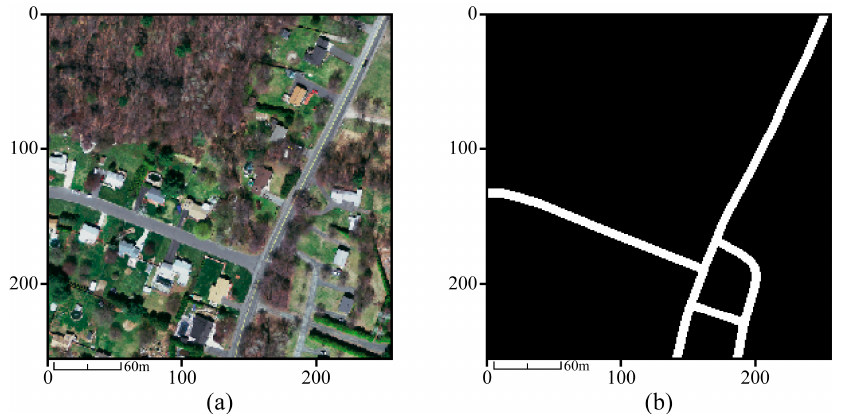
Figure 4. Samples of the remote sensing imagery used in the experiments. The RGB image ( a ) and the corresponding label ( b ).